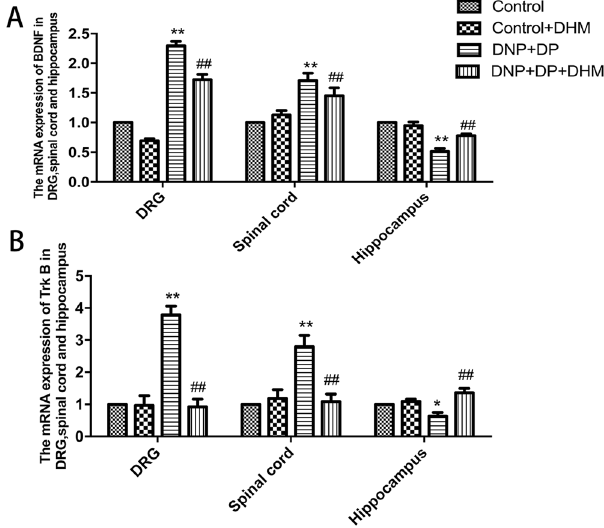
Figure 3. Effects of dihydromyricetin on the expression of BDNF ( A ) and TrkB ( B ) mRNA in the DRGs, spinal cord and hippocampus of rats with comorbid DNP and DP as detected by qRT-PCR. Values are the mean ± SEM of 6 observations. * p < 0.05 and ** p < 0.01 vs . control group; ## p < 0.01 vs . DNP + DP group.